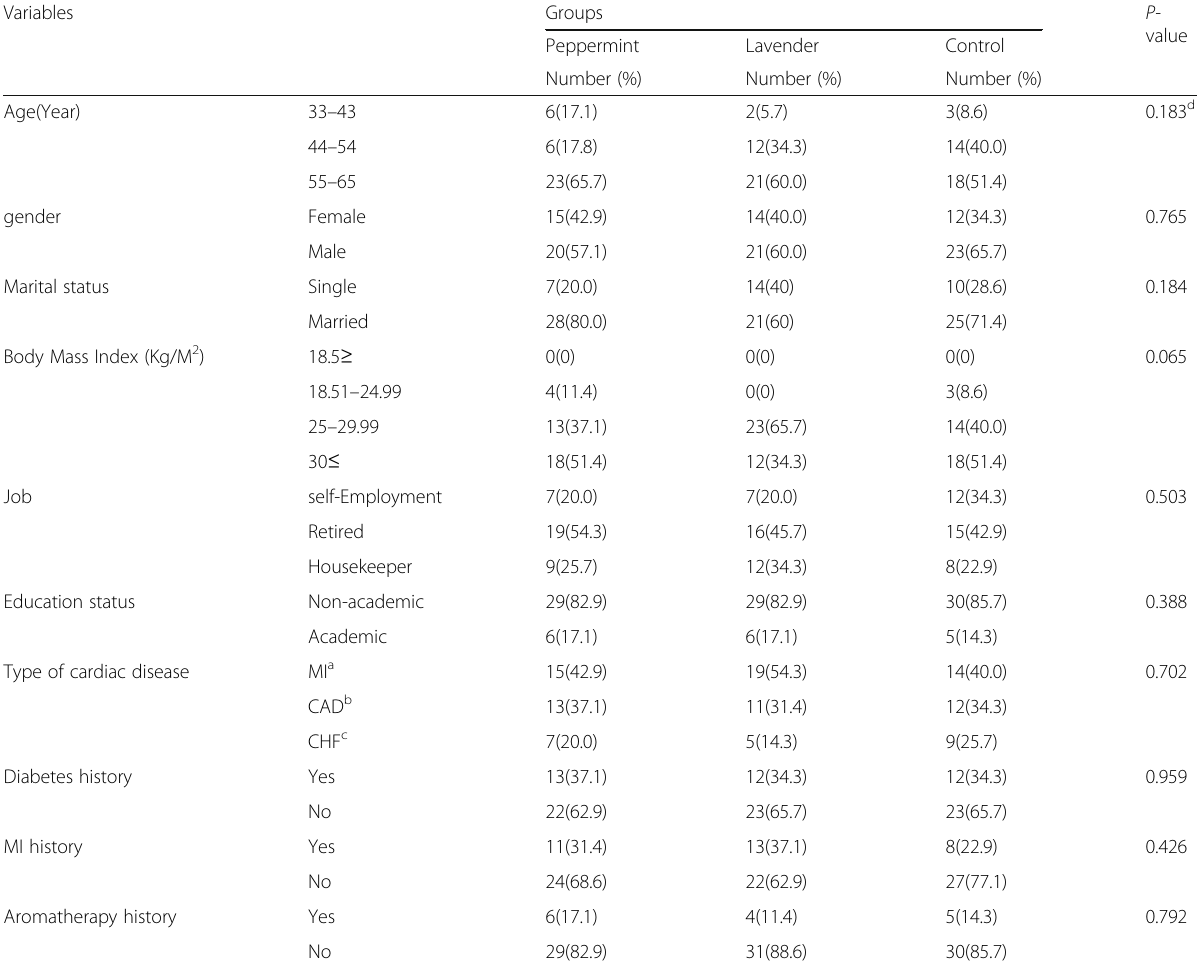
Table 1 Comparison of the demographic variables in the study groups Variables